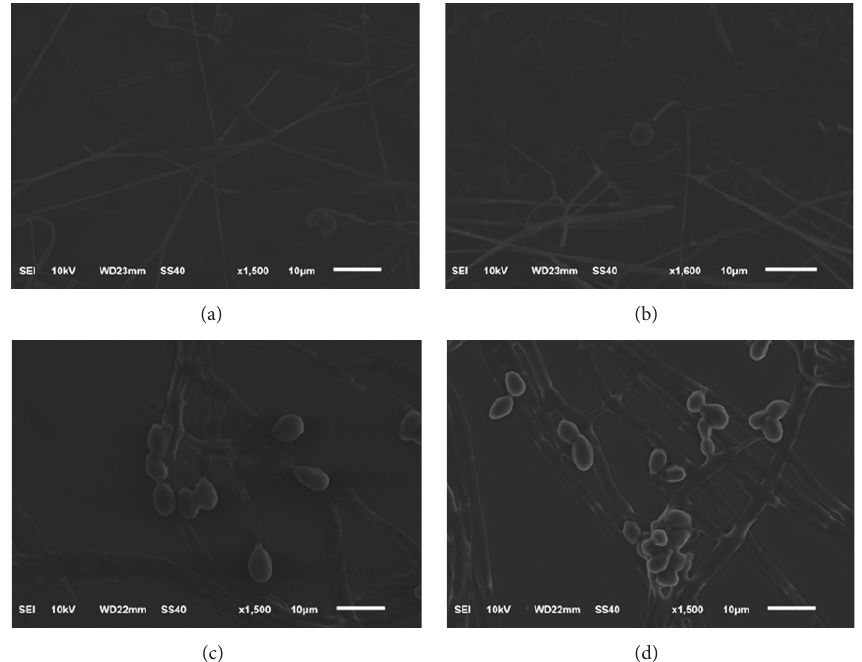
Figure 5: Cell morphology under SEM. (a) S. apiospermum CBS 117410 without UVC exposure; (b) S. apiospermum CBS 117410 after 15 min of UVC exposure; (c) L. prolificans CM324 without UVC exposure; and (d) L. prolificans CM324 after 15 min of UVC exposure.